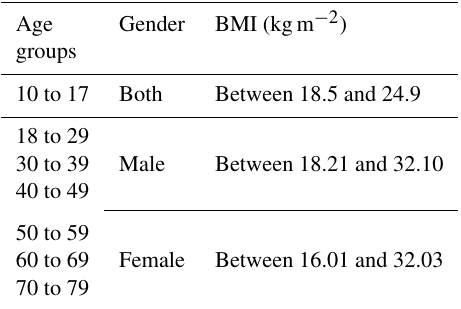
Table 1. Ranges of BMI used according to gender and age of indi- viduals (details in Prentice, 1998, and Bernardini et al., 2020).